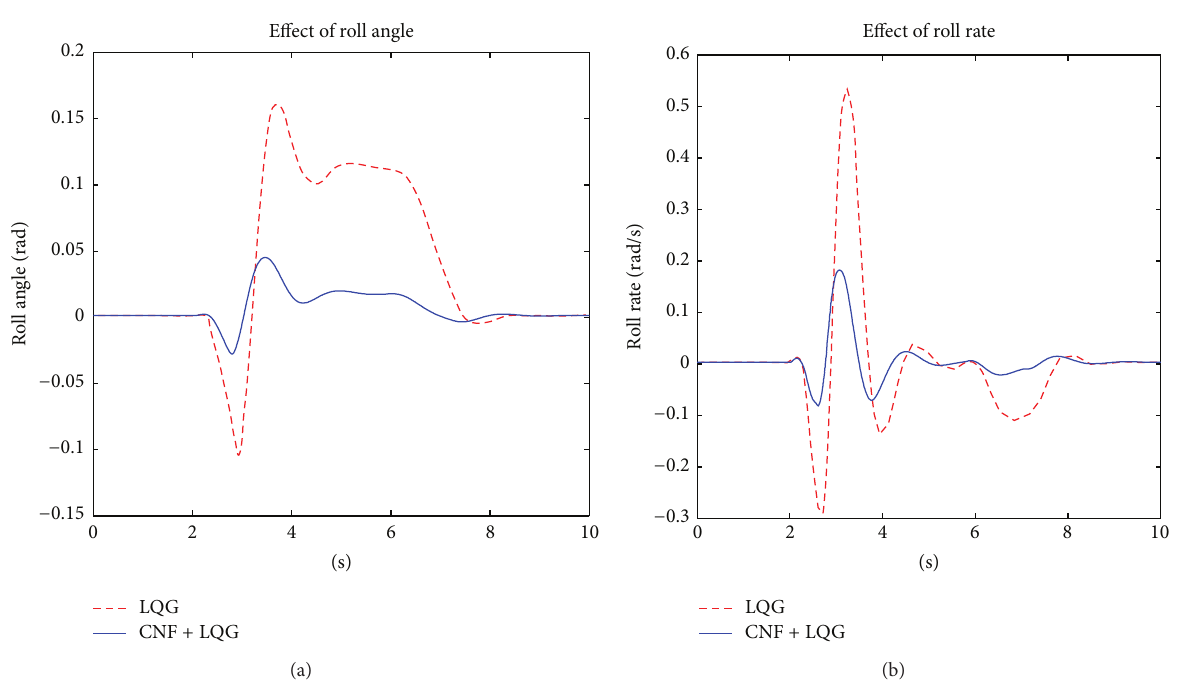
Figure 7: Fishhook test (a) roll angle response and (b) roll rate